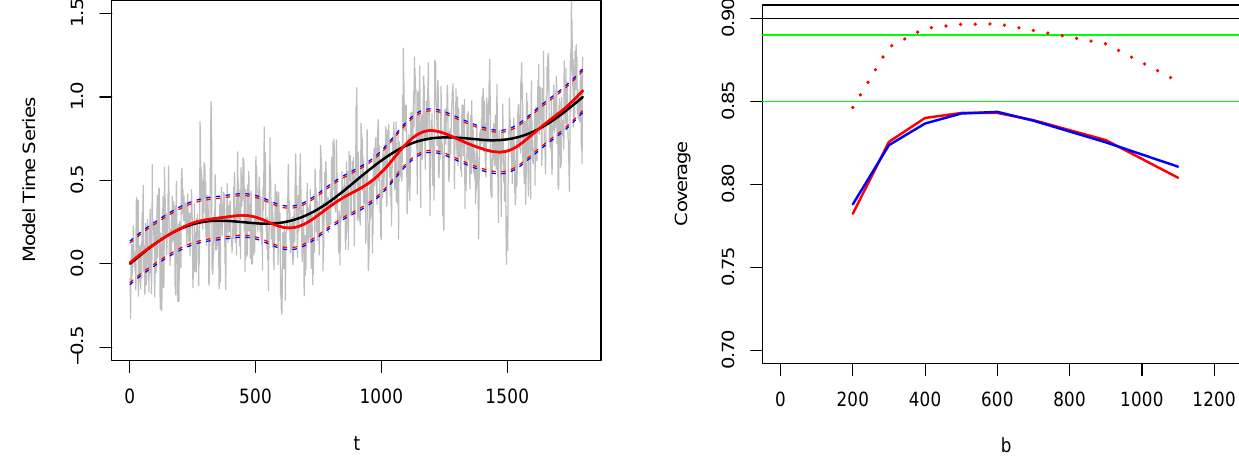
Fig. 4. A realization of time series (9) at a = 0 (gray curve), trend function m t (thick black curve), a trend estimate computed from the realization (thick red curve), a 90% SCB for the trend (dashed red curves) and calibrated 90% SCB for the trend (dashed blue curves).